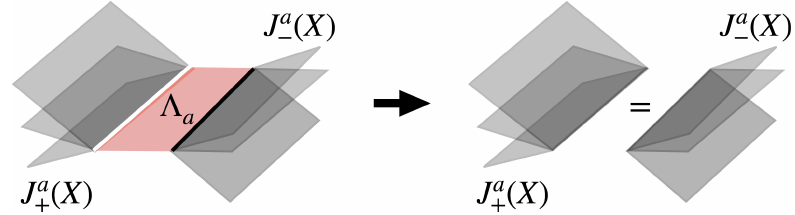
Figure 19 . Graphical representation of the J -term equations for a Fermi. The E -term equations are completely